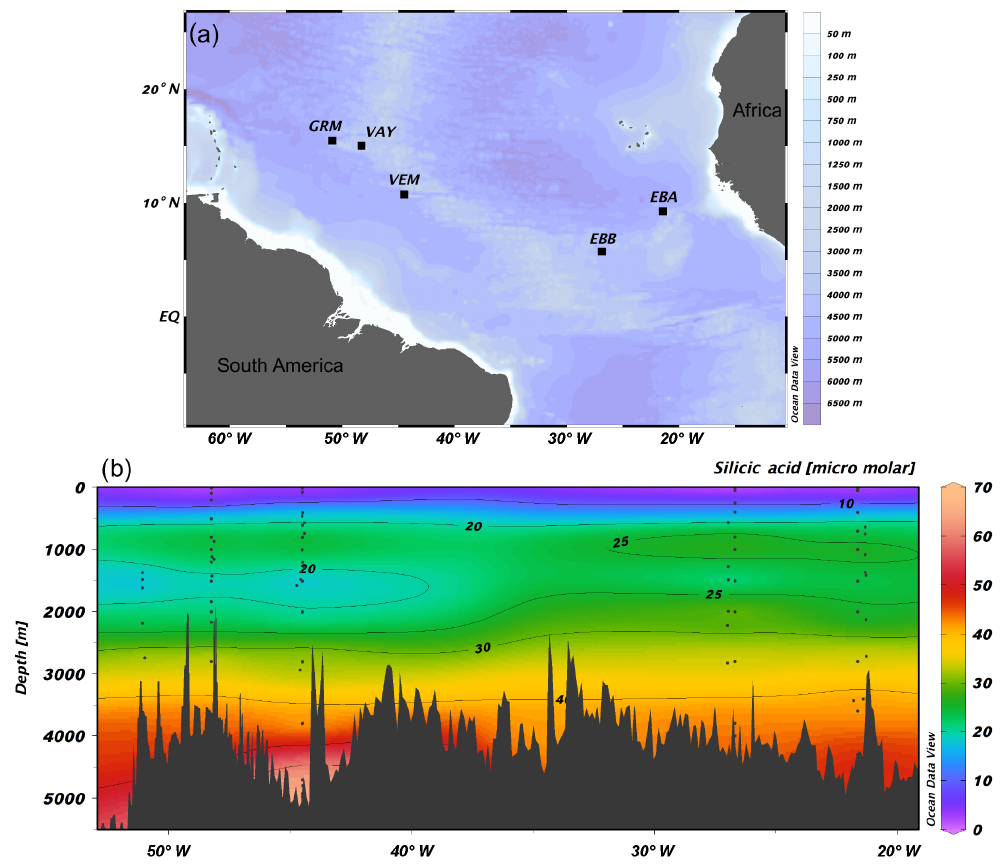
Figure 1. (a) JC094 sampling stations from the equatorial Atlantic. From east to west: EBA (Carter Seamount), EBB (Knipovich Seamount), VEM (Vema Fracture Zone), VAY (Vayda Seamount) and GRM (Gramberg Seamount). Cross section of DSi concentration in micromolar along the JC094 transect. Dots representing the sampling depth of stations, from east to west: EBA, EBB, VEM, VAY and